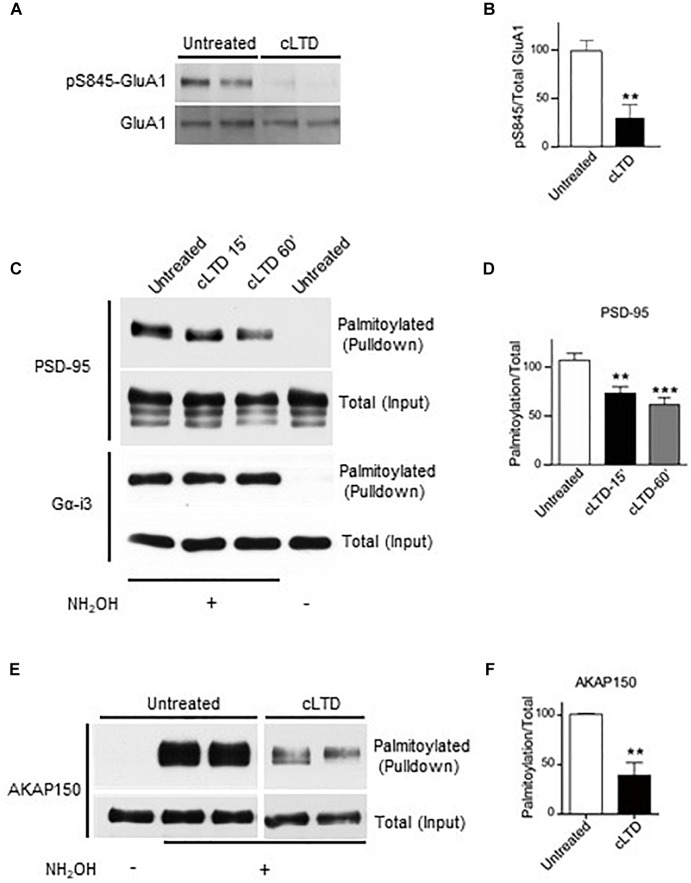
Effect of chemical LTD (cLTD) treatment on palmitoylation of endogenous PSD-95 and AKAP150. Cultured cortical neurons at DIV17 were either left untreated or treated with NMDA (50 μM) for 5 min followed by washout for 15 min (cLTD) before harvesting, extraction, and analysis of palmitoylation by ABE method and pulldown with NeutrAvidin agarose beads. (A) Total lysates were analyzed by immunoblotting to examine levels of S845 phosphorylation by immunoblotting with a phospho-specific antibody against phosphoS845. After stripping, the same blot was reprobed with an antibody against total GluA1. Representative immunoblots are shown. (B) Quantification of GluA1 S845 phosphorylation normalized to total GluA1 levels per condition. (∗∗p < 0.01; t-test, n = 4–5 per condition from three independent sets of cultures). Untreated condition was set to equal 100%. (C,E) Representative immunoblots of NeutrAvidin pulldown samples, representing palmitoylated proteins, and total lysate (input) for PSD-95, Gα-i3, and AKAP150. Omission of NH2OH before biotinylation resulted in no NeutrAvidin pull down as negative control for non-specific pull down. All lanes are from same blots and exposures but re-arranged to show only relevant lanes. (D,E) Quantification of PSD-95 and AKAP150 palmitoylation normalized to respective total inputs. (∗∗p < 0.01, ∗∗∗p < 0.001; t-test, n = 4–9 per condition from at least three independent sets of cultures). Untreated condition was set to equal 100% for each protein.